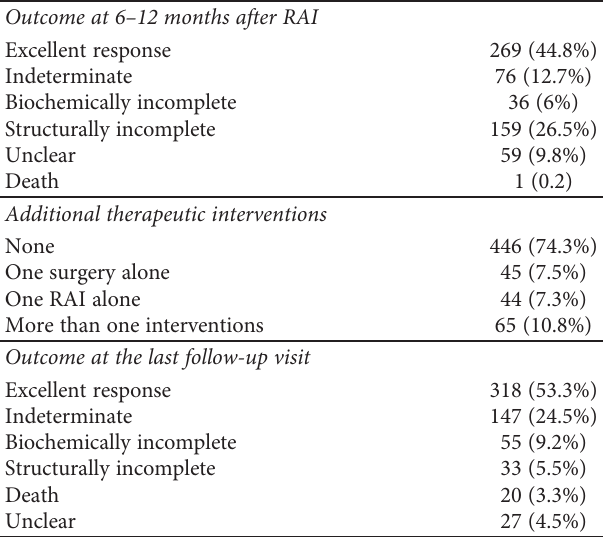
Table 3: Short- and long-term outcome of 600 DTC patients treated during the period